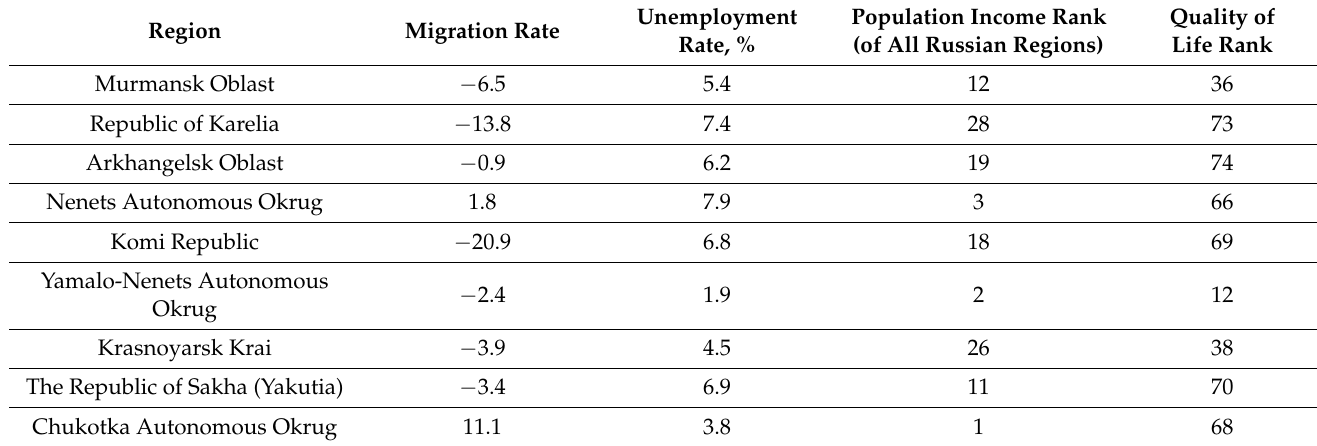
Table 1. Indicators of social development of the Arctic regions in